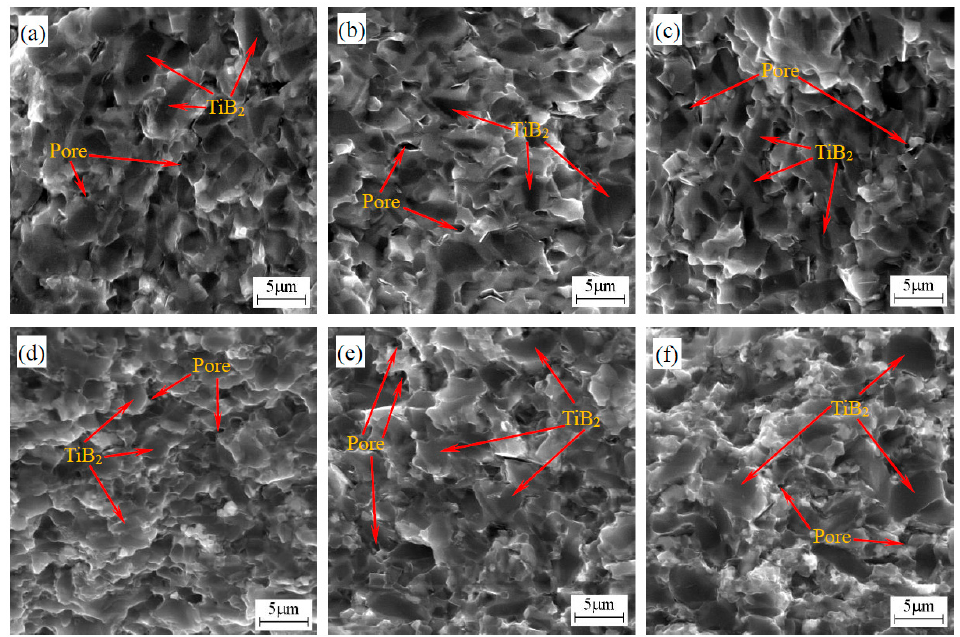
Figure 4. Fracture morphology of TiB 2 -HfB 2 and TiB 2 -HfN ceramic tool materials: ( a ) TiB 2 -10 wt % HfB 2 ; ( b ) TiB 2 -20 wt % HfB 2 ; ( c ) TiB 2 -30 wt % HfB 2 ; ( d ) TiB 2 -10 wt % HfN; ( e ) TiB 2 -20 wt % HfN;